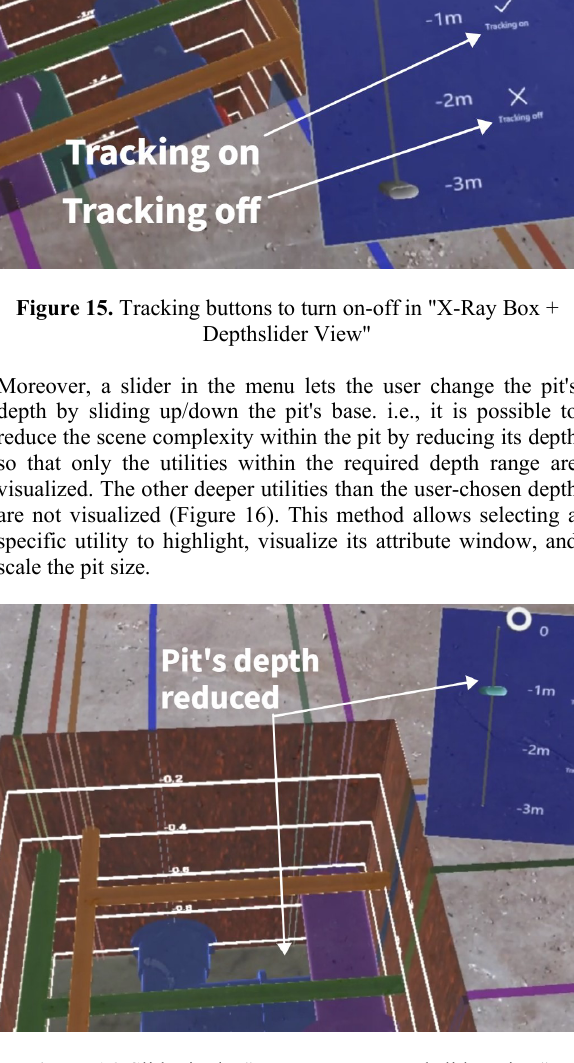
Figure 16 . Slider in the "X-Ray Box + Depthslider